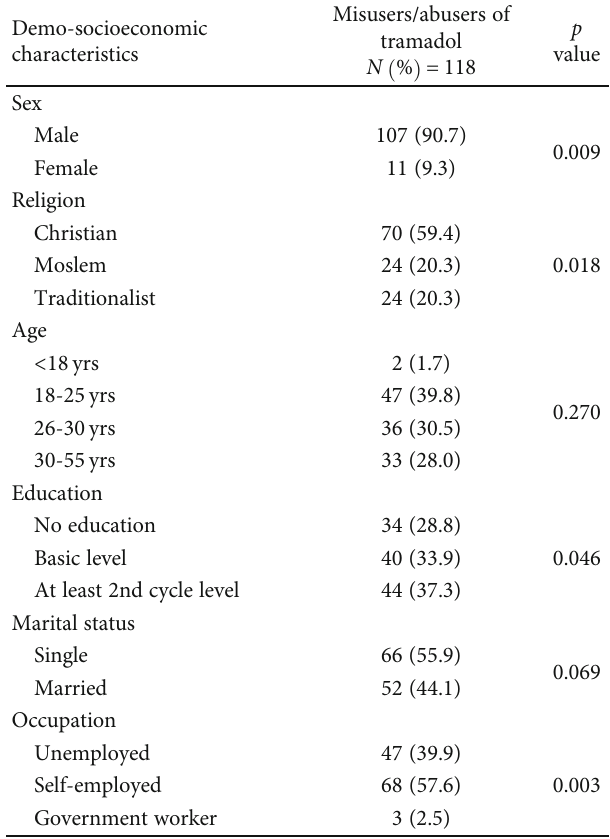
Table 6: Sociodemographic characteristics associated with tramadol abuse.